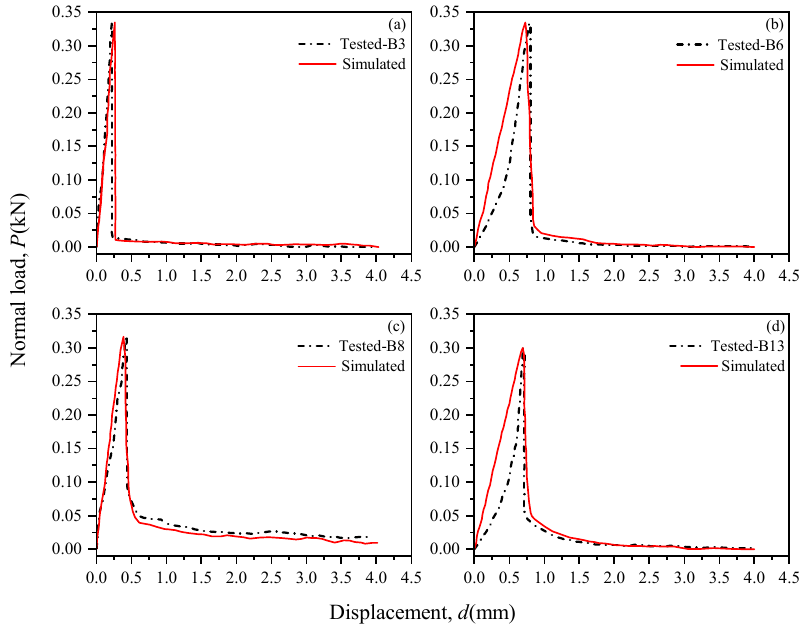
Figure 6. Simulation and test result [10] comparison of the three-point bending test of frozen soil specimens with a 1.0 mm/min loading rate: ( a ) Specimen’s temperature = − 3.2 °C; ( b ) Specimen’s temperature = − 2.66 °C; ( c ) Specimen’s temperature = − 1.7 °C; ( d ) Specimen’s temperature = − 0.97 °C.